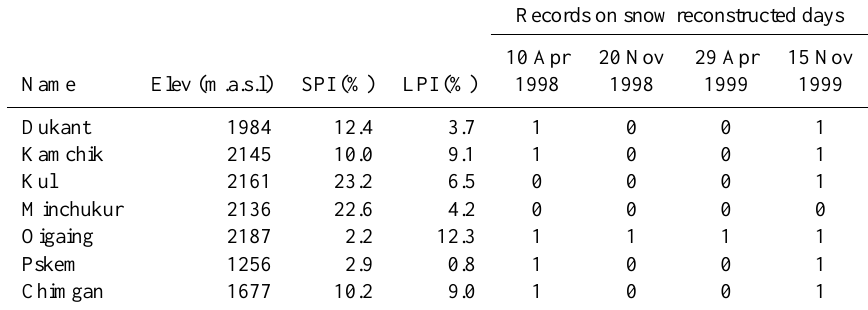
Table 1. Uzhydromet snow observation stations with indication of elevation (Elev), and snow predictability index (SPI) and land predictabil- ity index (LPI) values for the study area (see Sect. 4). The entries “records on snow reconstructed days” indicate whether a station was snow covered (0) or snow free (1) during a day for which snow-cover reconstruction was conducted and Landsat scenes were available for